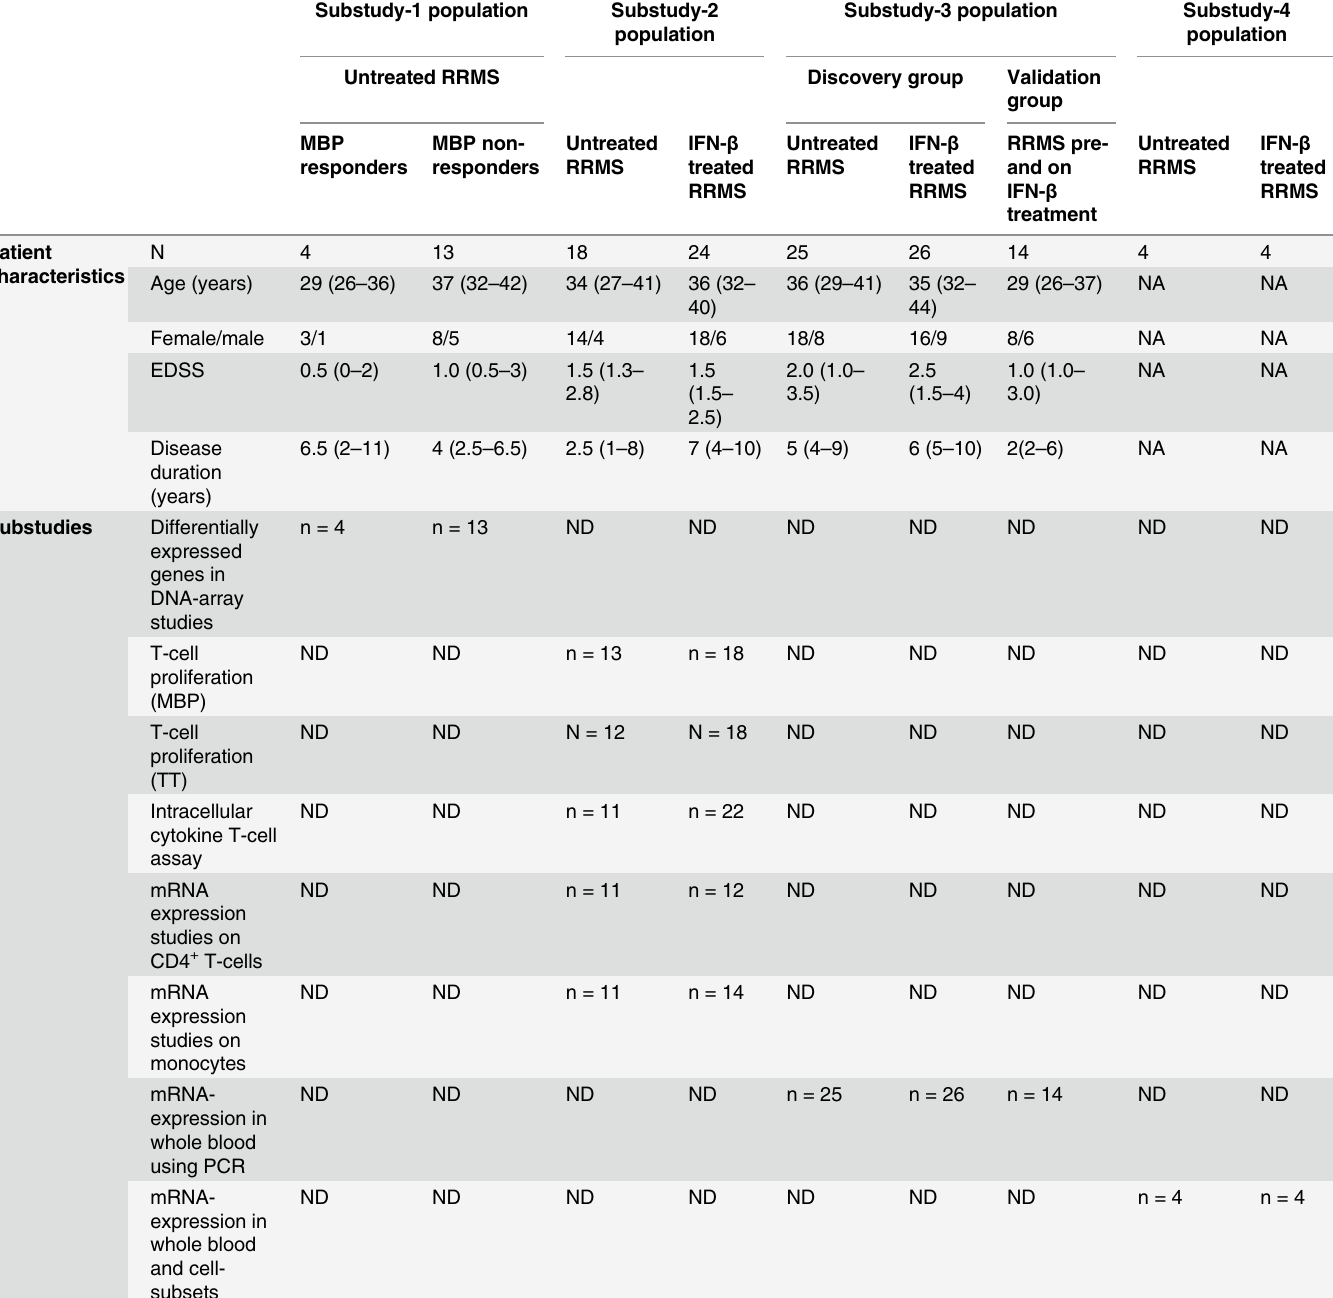
Table 1. Characteristics of relapsing-remitting multiple sclerosis (RRMS) patients included in this